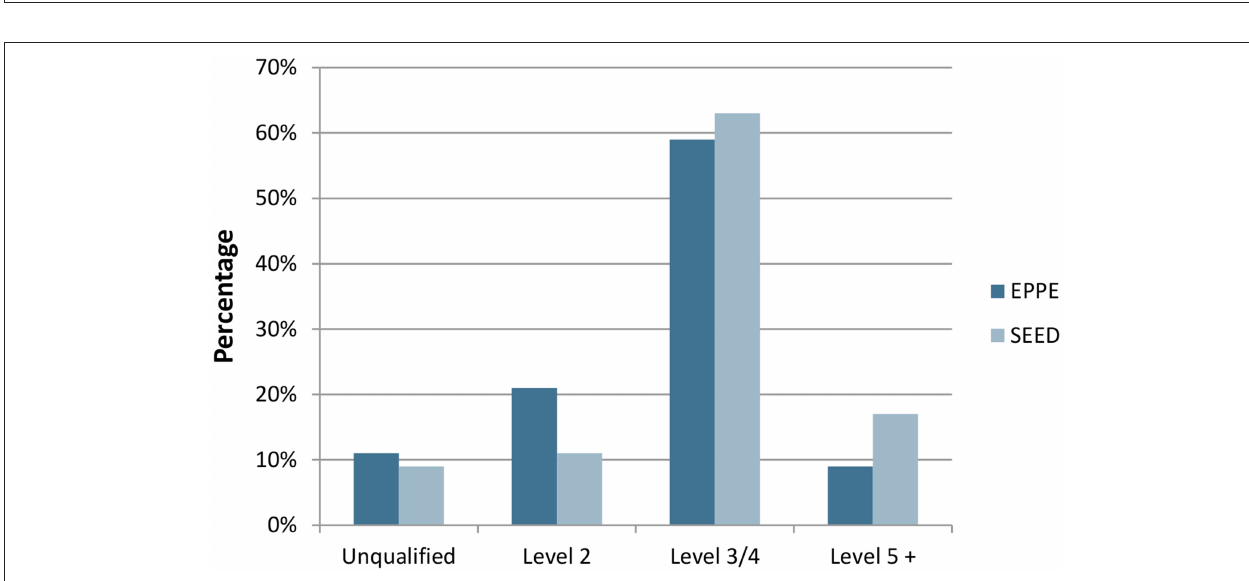
FIGURE 4 | Comparison of level of staff qualification in the EPPE and SEED studies. Figure © 2017 NatCen Social Research, University of Oxford and Action for Children, reproduced with